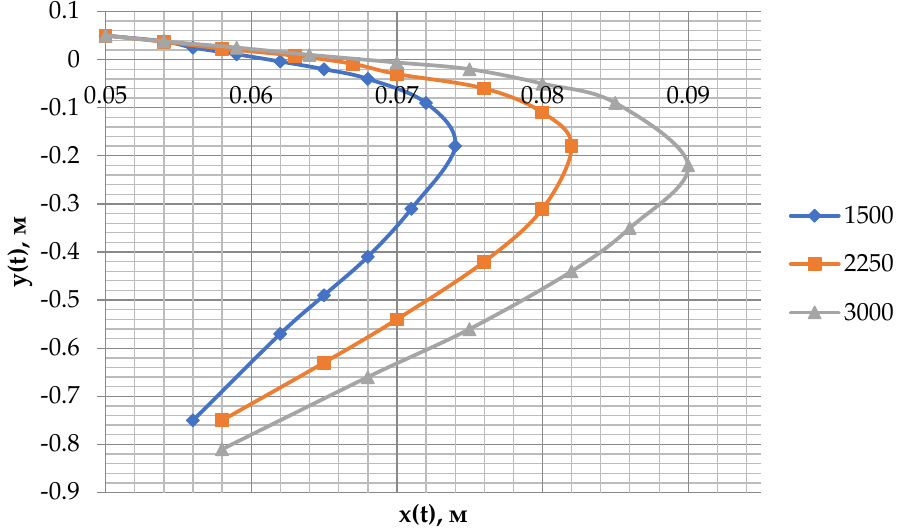
Figure 6. Dependence of the particle motion at rotation frequencies n = 1500, 2250 and 3000 min − 1 .